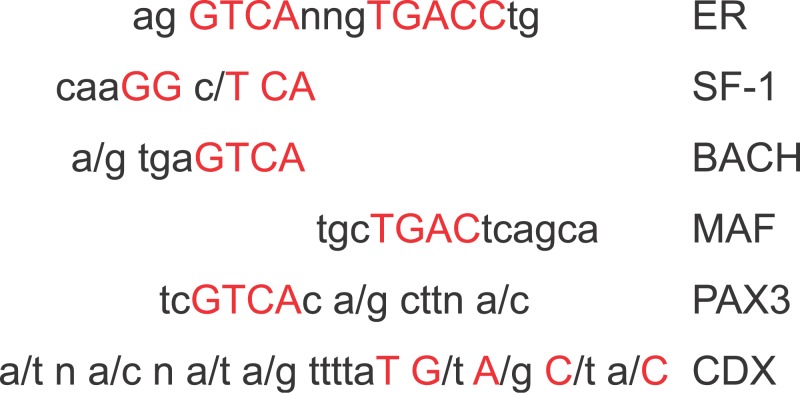
Alignment of TFBSs Enriched in ChIP-PET Clusters with Overlapping Sequence Motifs with the EREThe consensus string is a representation of the matrix based on the following rules [48]: A single nucleotide is shown if its frequency is greater than 50% and at least twice as high as the second most frequent nucleotide; a double-degenerate code indicates that the corresponding two nucleotides occur in more than 75% of the underlying sequences, but each of them is present in less than 50%; all other frequency distributions are represented by the letter “n;” the letters in red indicate bases identical to the ERE consensus.